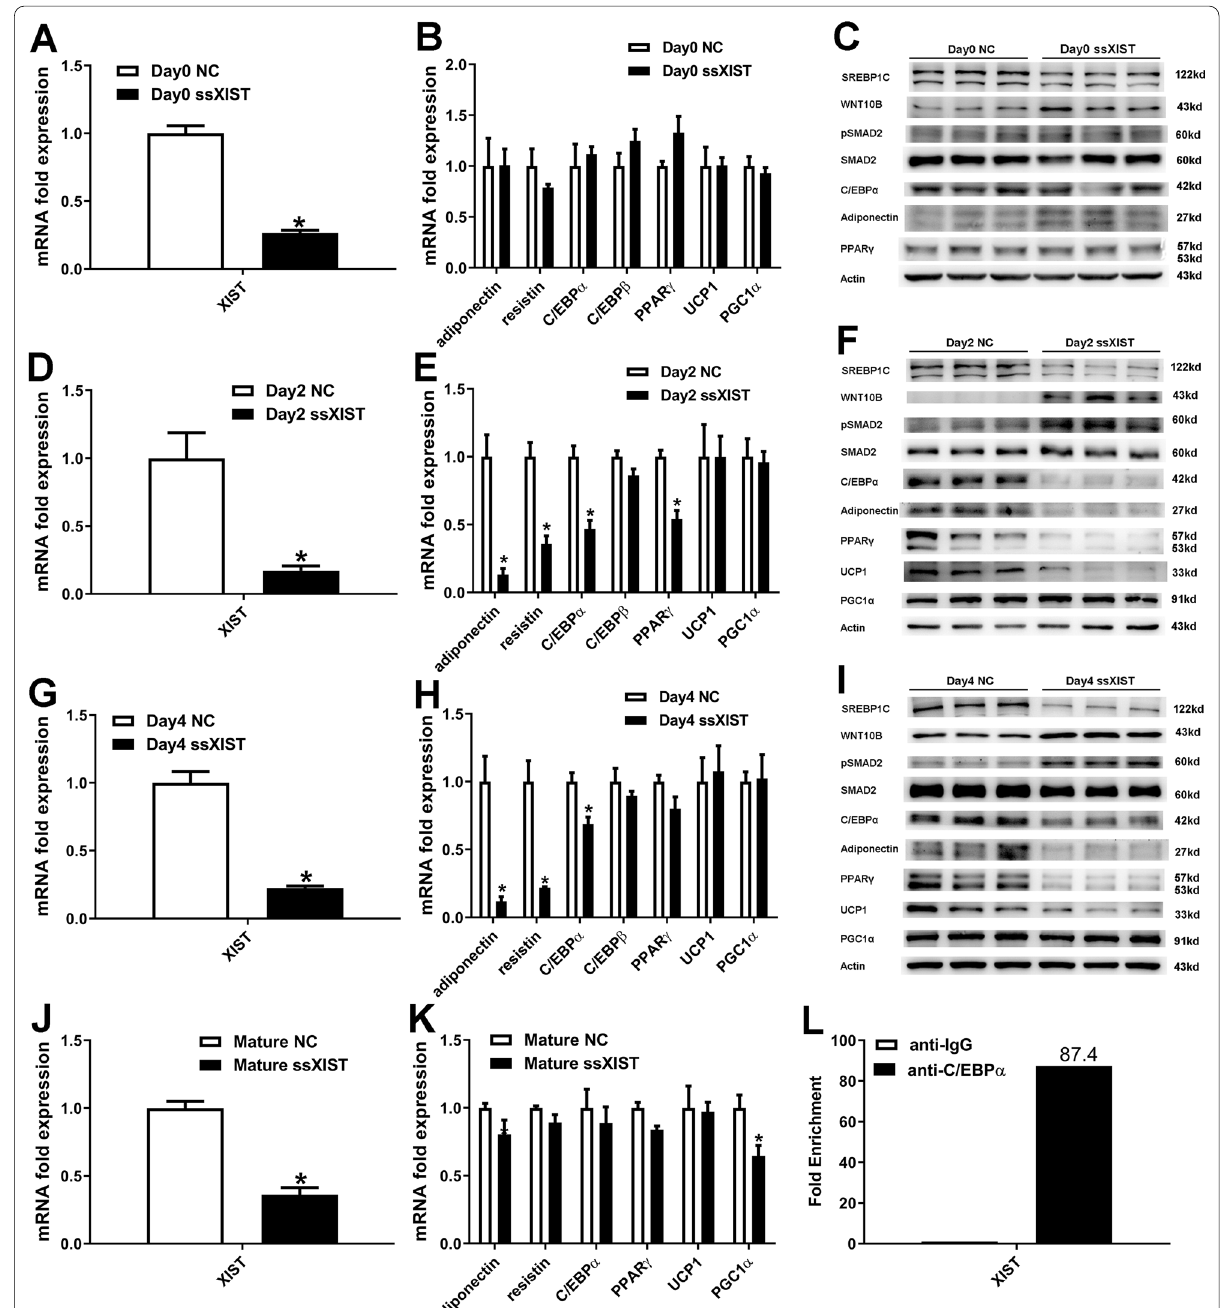
Fig. 3 Silencing of XIST inhibits brown preadipocyte differentiation. A – B , D – E , G – H qRT-PCR analysis of XIST and indicated genes during the differentiation of brown preadipocytes transfected with control or XIST smart silencer. C , F , I Western blot analysis of the expression of indicated proteins during the differentiation of brown preadipocytes transfected with control or XIST smart silencer. J – K qRT-PCR analysis of XIST and indicated genes in differentiated brown preadipocytes transfected with control or XIST smart silencer. L RNA-binding protein immunoprecipitation (RIP) assay showing the interaction between XIST and C/EBPα. *, p < 0.05. Data are represented as mean ±